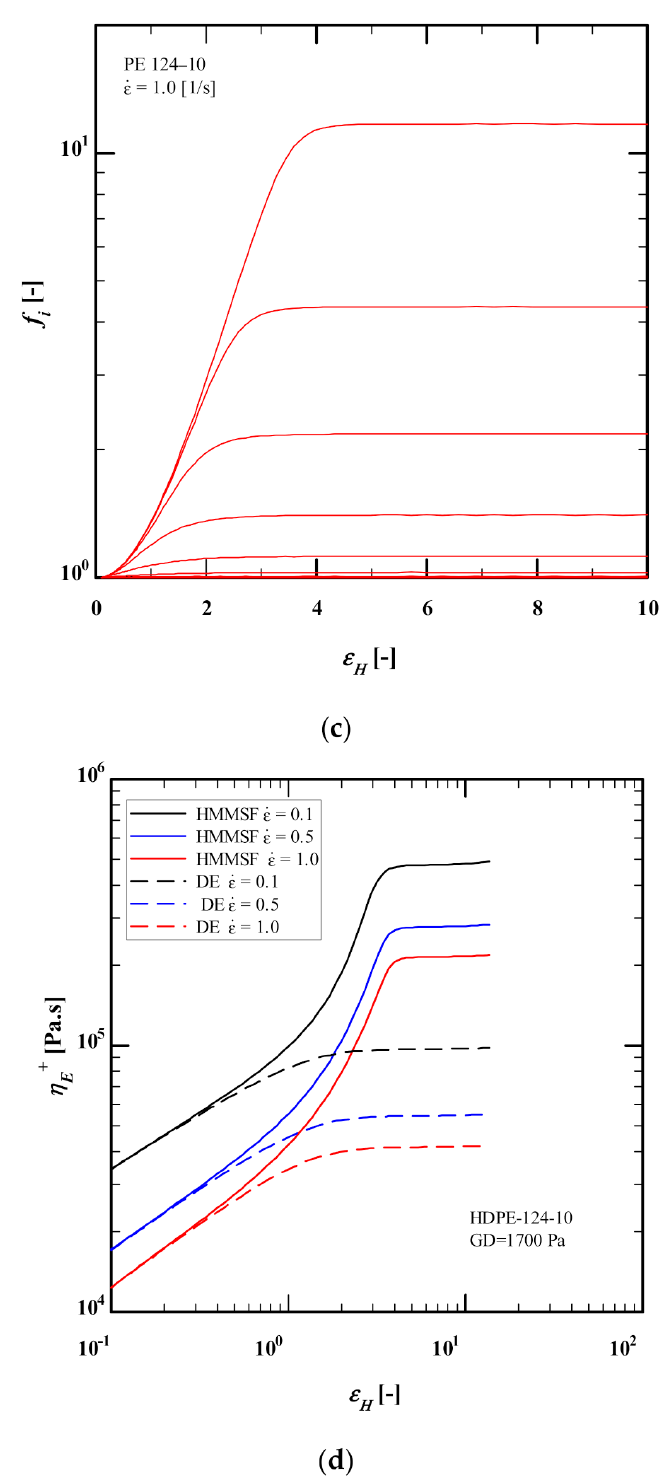
Figure 11. Spectral decomposition of stretch as a function of Hencky strain for PE 124-10 at . . . ε = 0.1/s, ( b ) ε = 0.5/s, ( c ) ε = 1/s and ( d ) comparison between the predictions of the ( a ) DE and HMMSF models as functions of Hencky